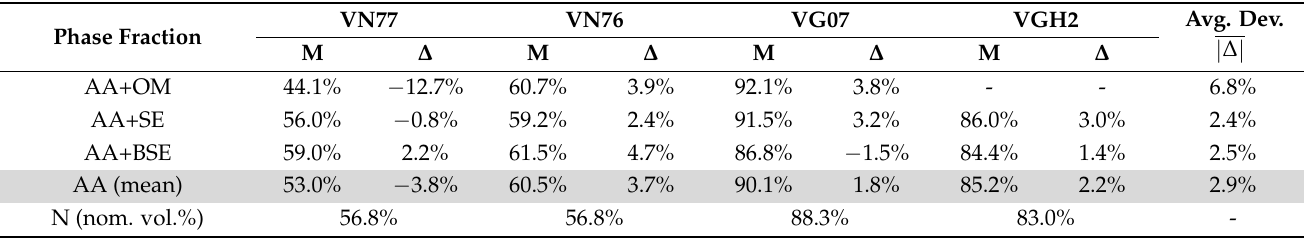
Table 12. Phase fractions (vol%) of WC grains obtained by the AA.